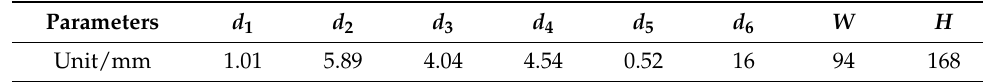
Table 2. Size of a three-dimensional